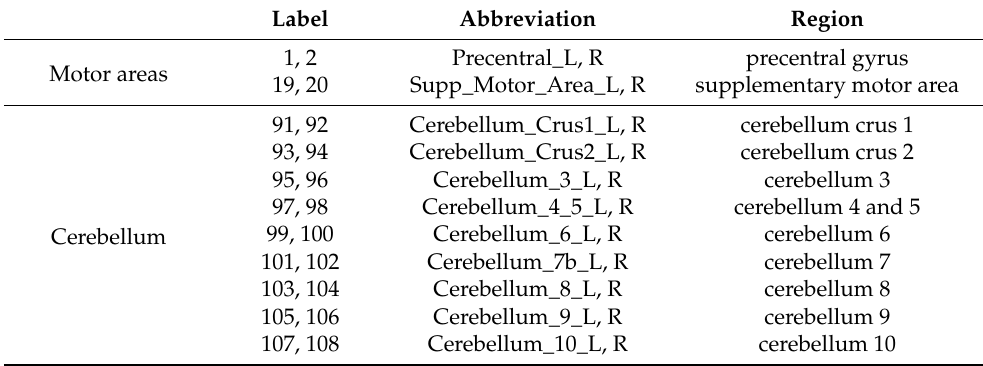
Table 2. Motor-related areas of the Automatic Anatomical Labelling (AAL) atlas used to compute functional connectivity values. Odd numbers indicate the left hemisphere (L), while even numbers indicate the right hemisphere